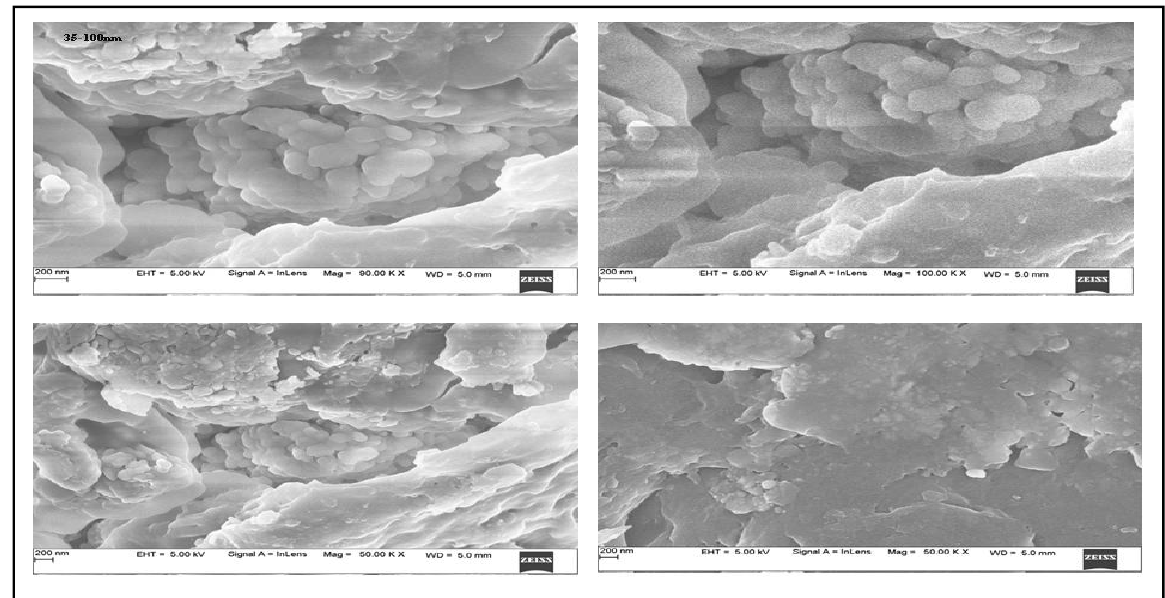
Figure 3. SEM images of R. apiculata AgNPs show an uneven shape and a diameter of 35–100 nm.